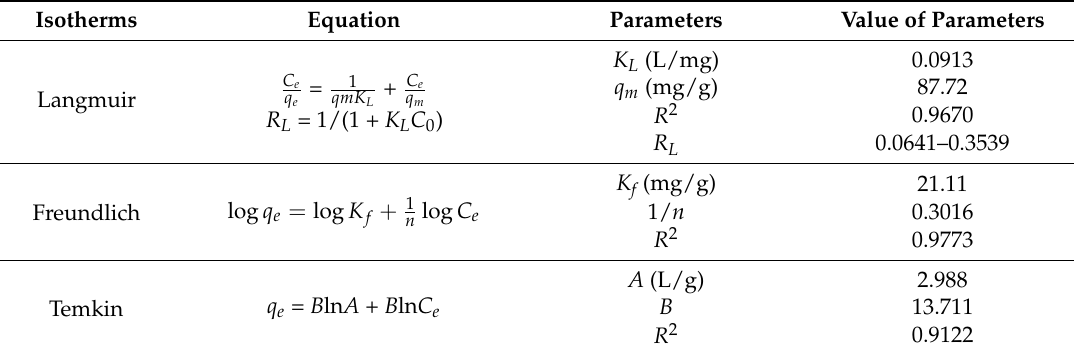
Table 5. Langmuir, Freudlich, and Temkin isotherm parameters for the removal of Rh B by nZVI/rGO.